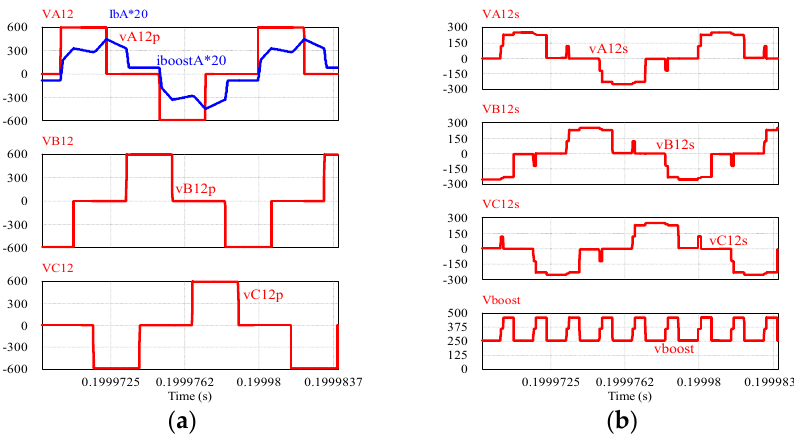
Figure 10. PSIM simulation waveforms for Case 2: V in (max) = 270 V, full load, R L = 16 Ω , δ = 84 o . ( a )– ( b ) Figure 6 waveforms repeated.